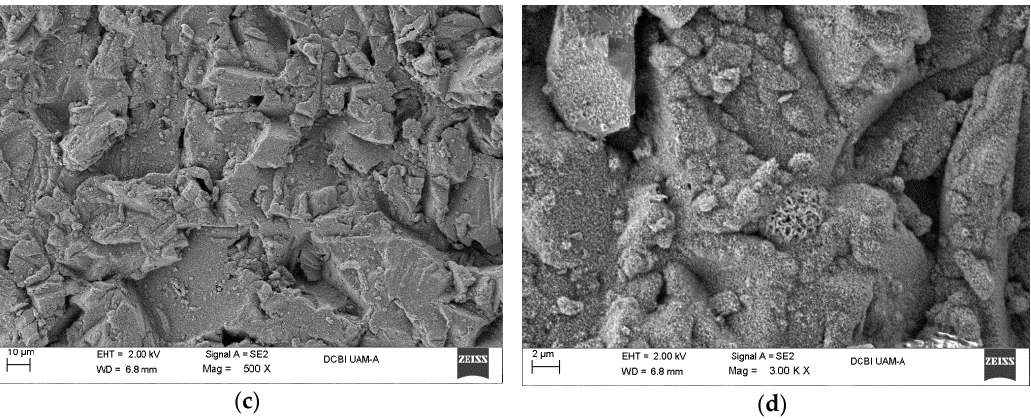
Figure 6. SEM micrographs of aluminum specimens after immersion treatment in water at 85 °C for 20 min, at different magnifications: ( a ) 500×; ( b ) 1 K×, and 60 min treatment; ( c ) 500×; ( d ) 3 K×. Table 3. EDS analysis of the aluminum substrate surface treated with hot water.